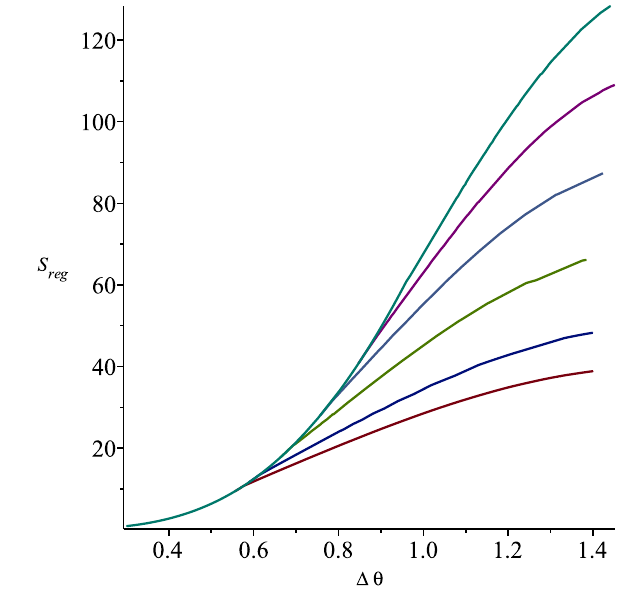
Figure 17 . Regulated entanglement entropy as a function of subregion size for ~ T = 0 : 5 ; r H = 3 L AdS ; r max = 100. Plots from bottom to top show t=L AdS = 0 ; 0 : 1 ; 0 : 2 ; 0 : 3 ; 0 : 4 ; 0 : 5.